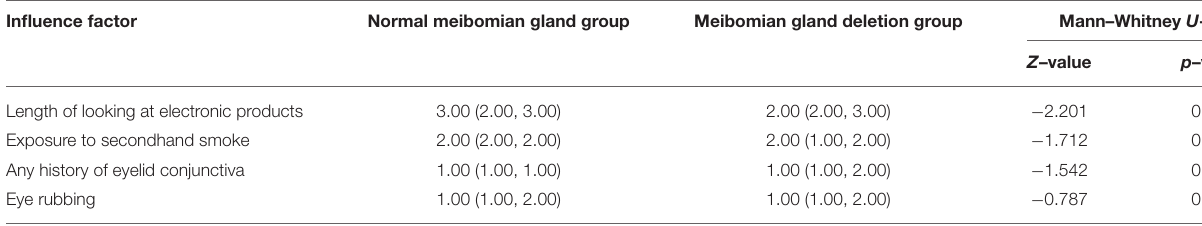
TABLE 4 | Analysis of influencing factors of meibomian gland deletion.